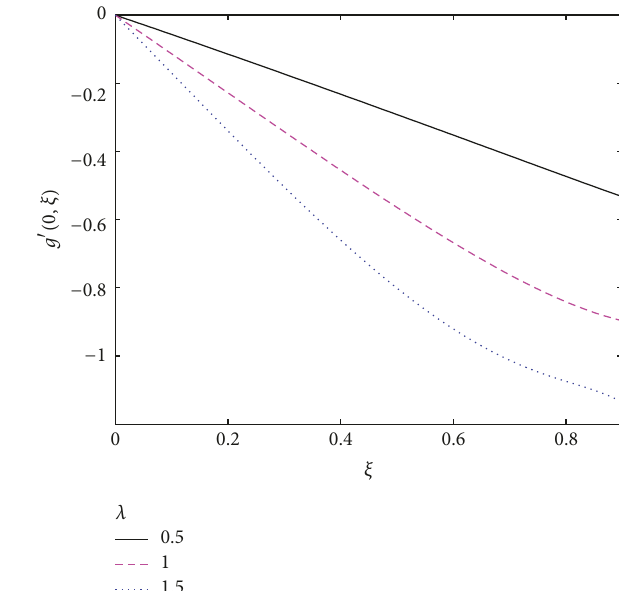
Figure 12: Effect of Pr on 𝑓 󸀠󸀠 (0, 𝜉) ( 𝜎 = 𝛾 = 0.5, 𝜆 = 1, Sc = 2, ℏ = −0.5 ).